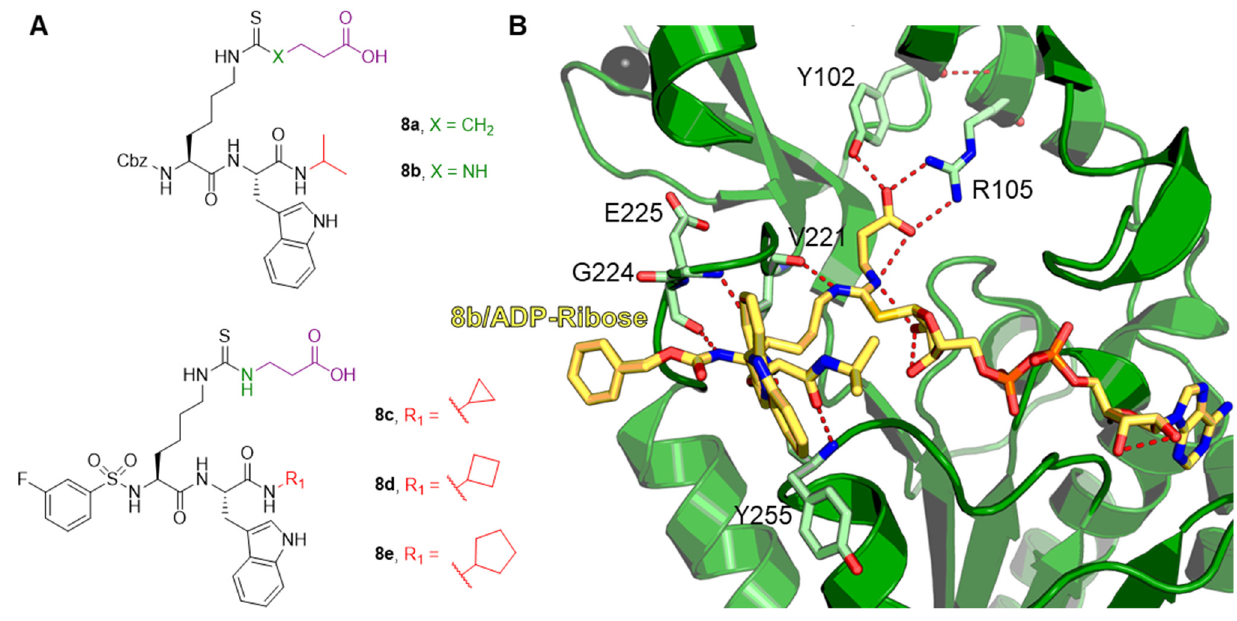
Figure 8. ( A ) Structures of compounds 8a – e . ( B ) Focus on the binding site of hSIRT5 in complex with the ADP ‐ ribose ‐ 1 ′‐ thioimidate intermediate of compound 8b (yellow) (PDB ID 6EQS).